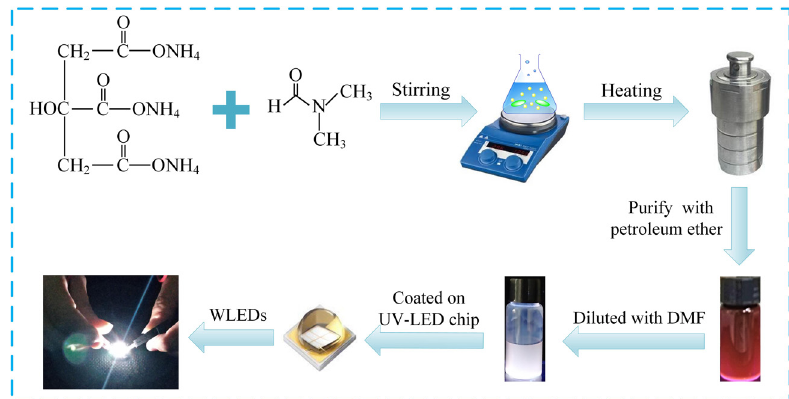
Figure 1: Schematic illustration of the preparation of RCQDs and SCWE - CQDs using a facile hydrothermal method with ammonium citrate ( AC ) , N,N - dimethylformamide ( DMF ) , and their application in